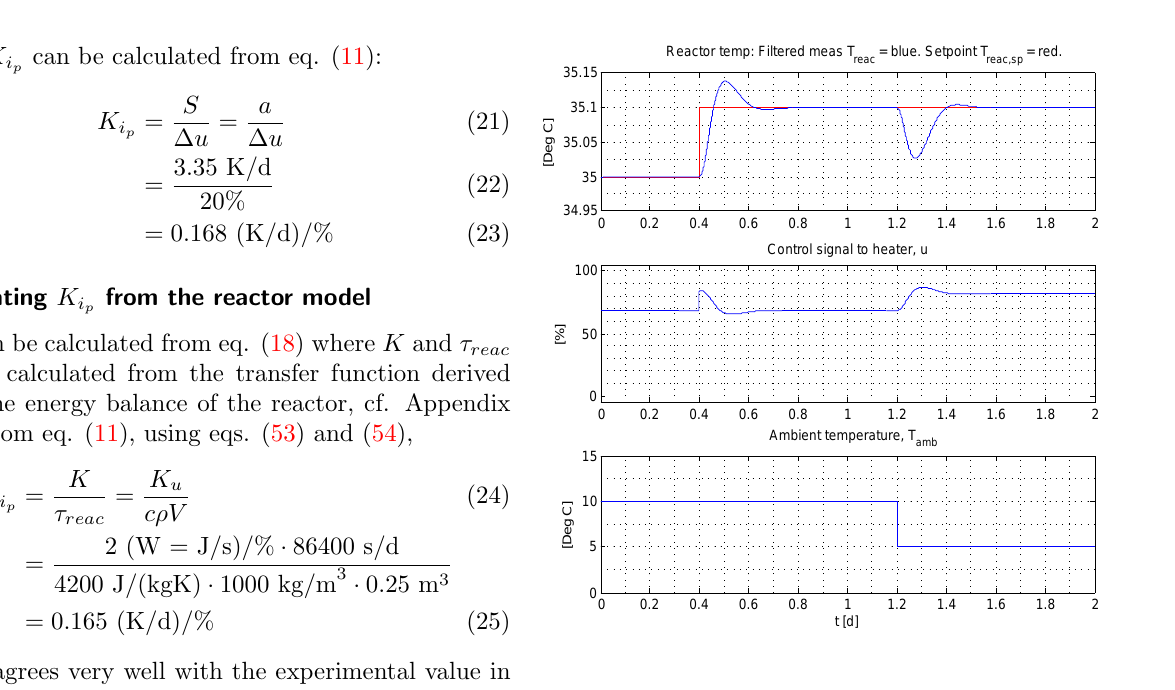
Figure 7: Simulations of temperature control system with the Skogestad PI